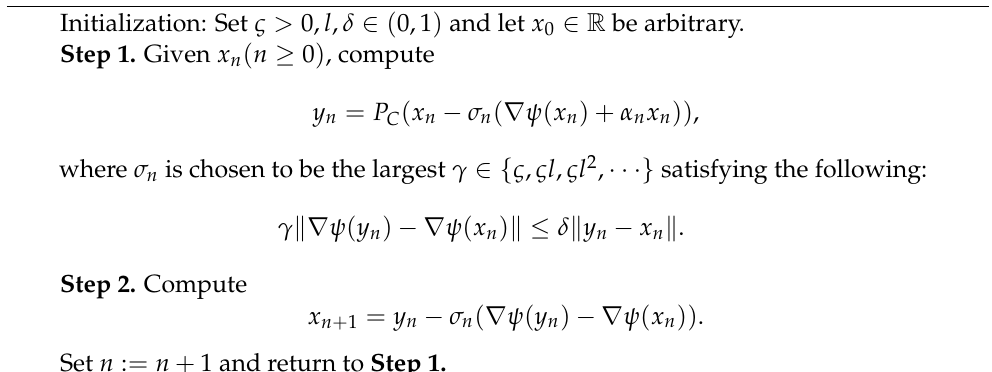
Algorithm 4: The Tseng’s extragradient method with regularization for mini- mization